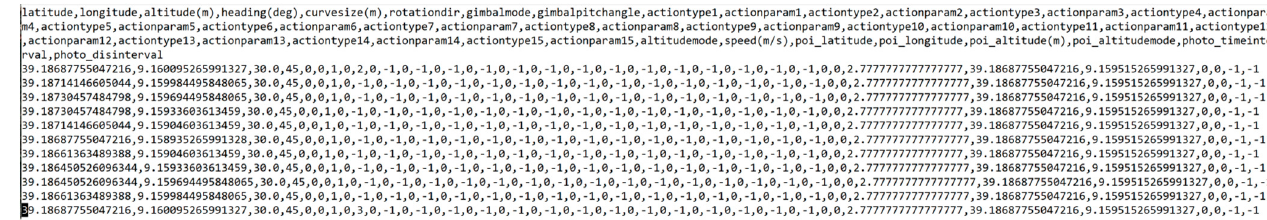
Figure 6. An example of a CSV file related to a mission.